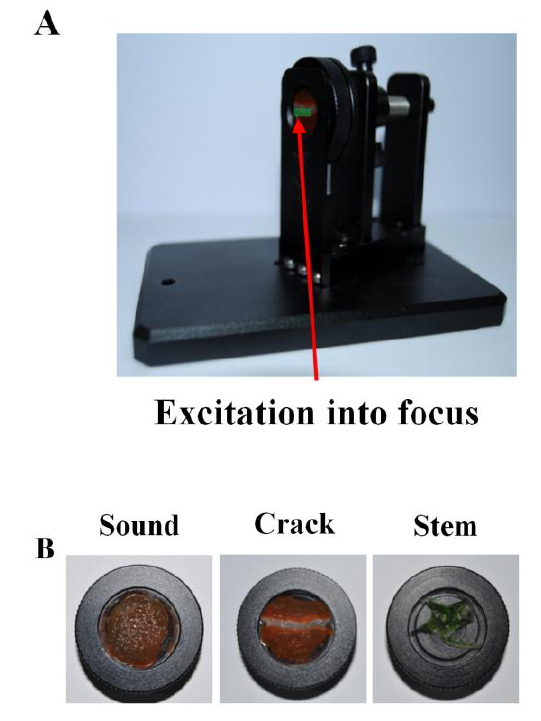
Figure 1. Photos of cell unit ( A ); precision cell with samples ( B